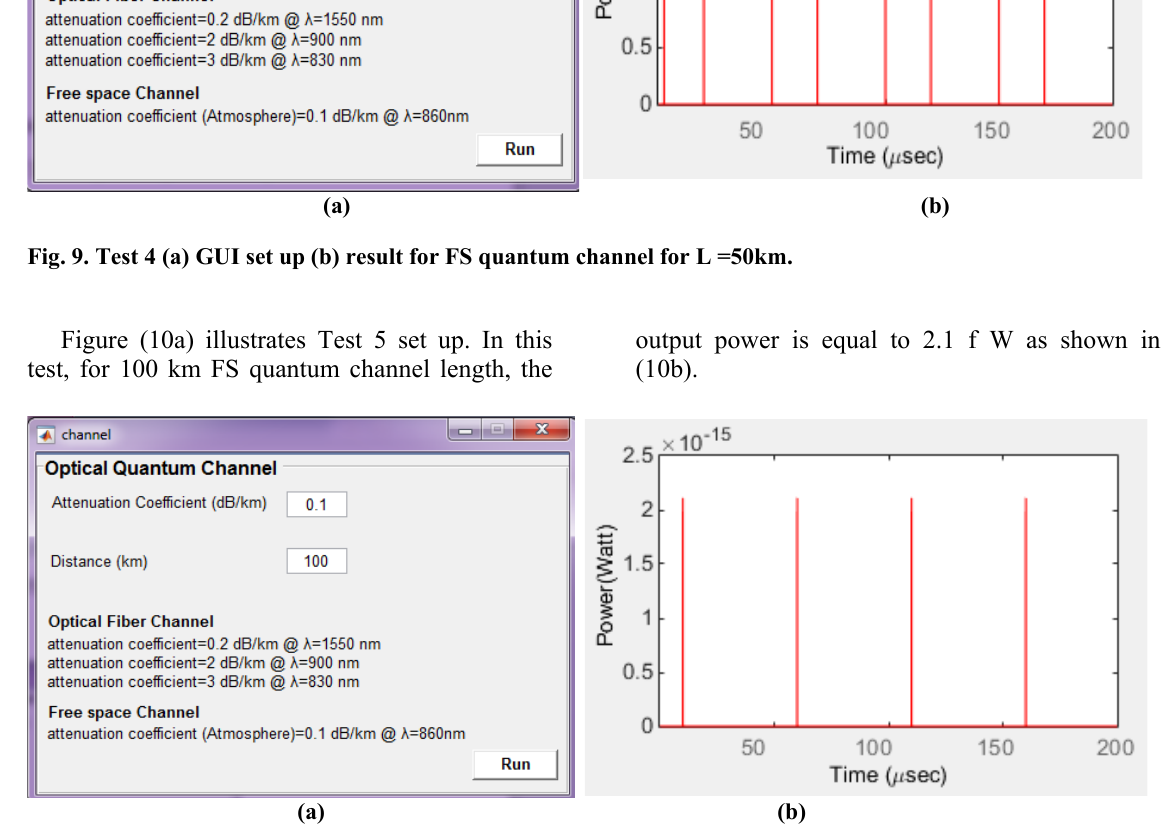
Fig. 10. Test 5 (a) GUI set up (b) result for FS quantum channel for L=100km.